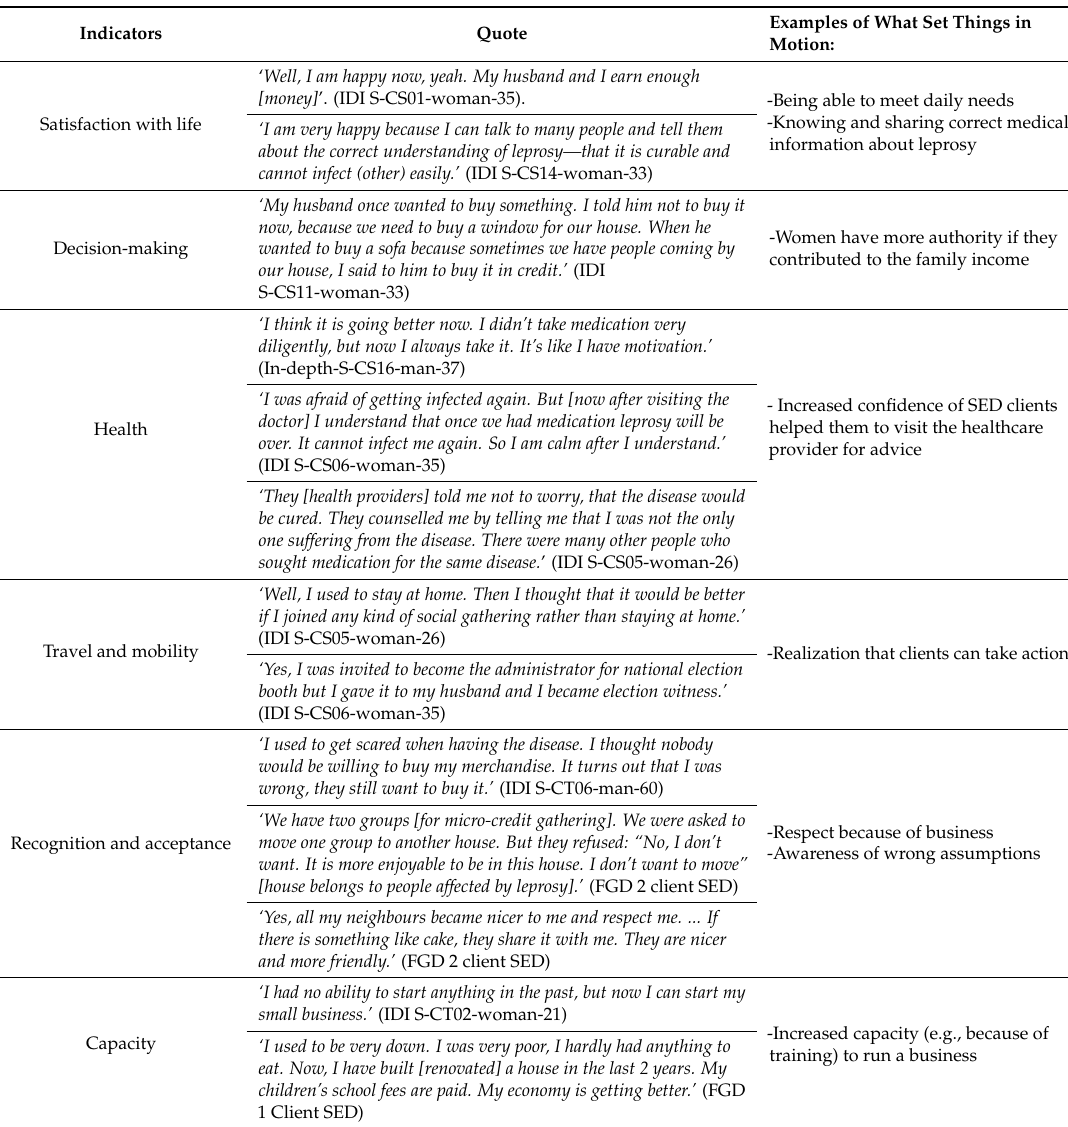
Table 7. Indicators of social transformation derived from IDIs and FGDs with SED participants. Indicators Quote